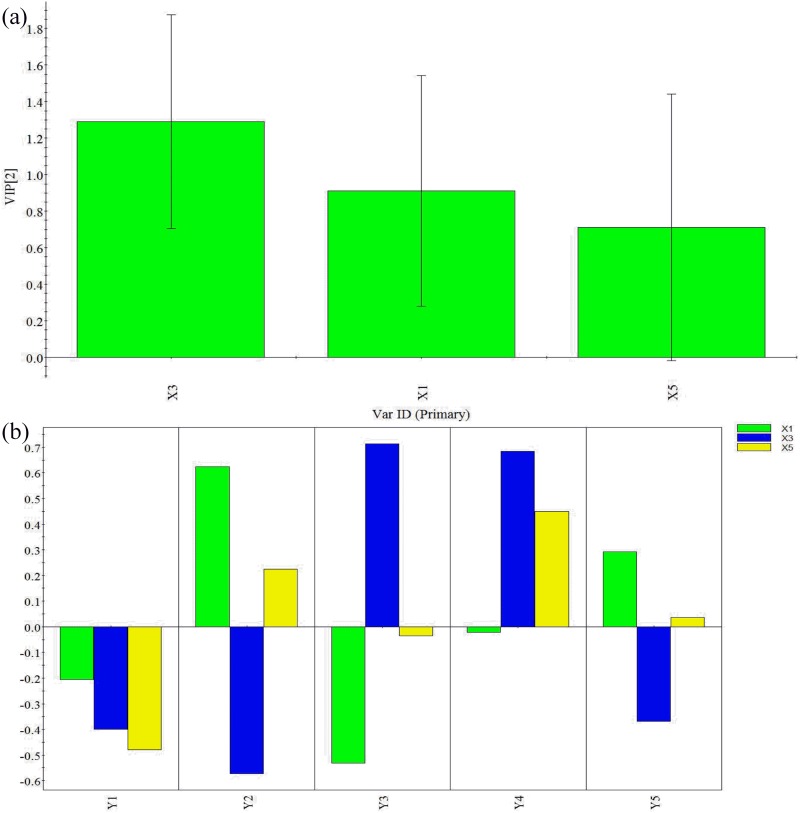
(a) VIP and (b) coefficients for the PLS model.